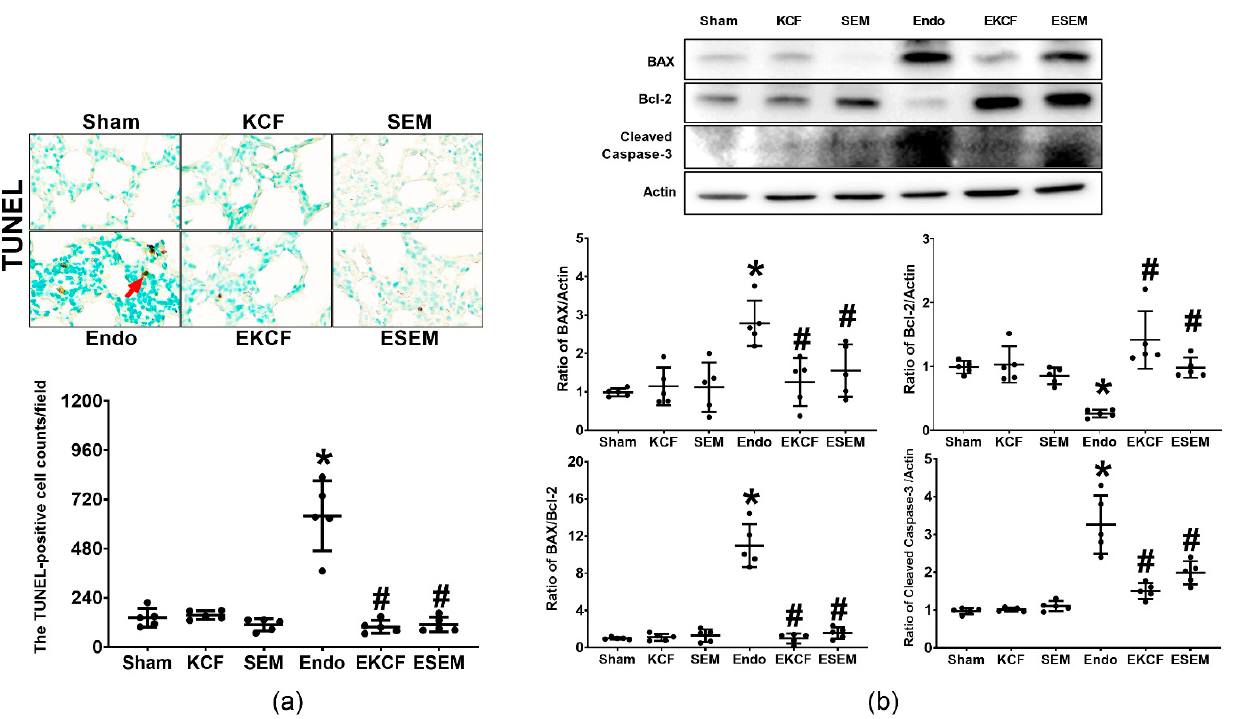
Figure 8. Lung apoptosis status. ( a ) Representative DNA fragmentation microscopic images (the indicator of apoptosis, marked by the red arrow, 200 × ) in lung tissues assayed using the terminal deoxynucleotidyl transferase dUTP nick end labeling (TUNEL) method and the count of TUNEL- positive cells (0.25 mm 2 ). ( b ) Representative gel images of the proapoptotic BAX, the antiapoptotic Bcl-2, proapoptotic cleaved caspase-3, and actin (the internal standard) in lung tissues assayed using immunoblotting assay and the relative band density of BAX/actin, Bcl-2/actin, cleaved caspase- 3/actin, and BAX/Bcl-2 ratios in lung tissues. All assays were measured at 24 h after endotoxin or normal saline administration. Sham: the normal saline group. KCF: the normal saline plus the KCF18 peptide group. SEM: the normal saline plus the SEM18 peptide group. Endo: the endotoxin group. EKCF: the endotoxin plus the KCF18 peptide group. ESEM: the endotoxin plus the SEM18 peptide group. Data were obtained from 5 mice in each group and presented as the mean ± standard deviation. * p < 0.05, versus the Sham group. # p < 0.05, versus the Endo group.